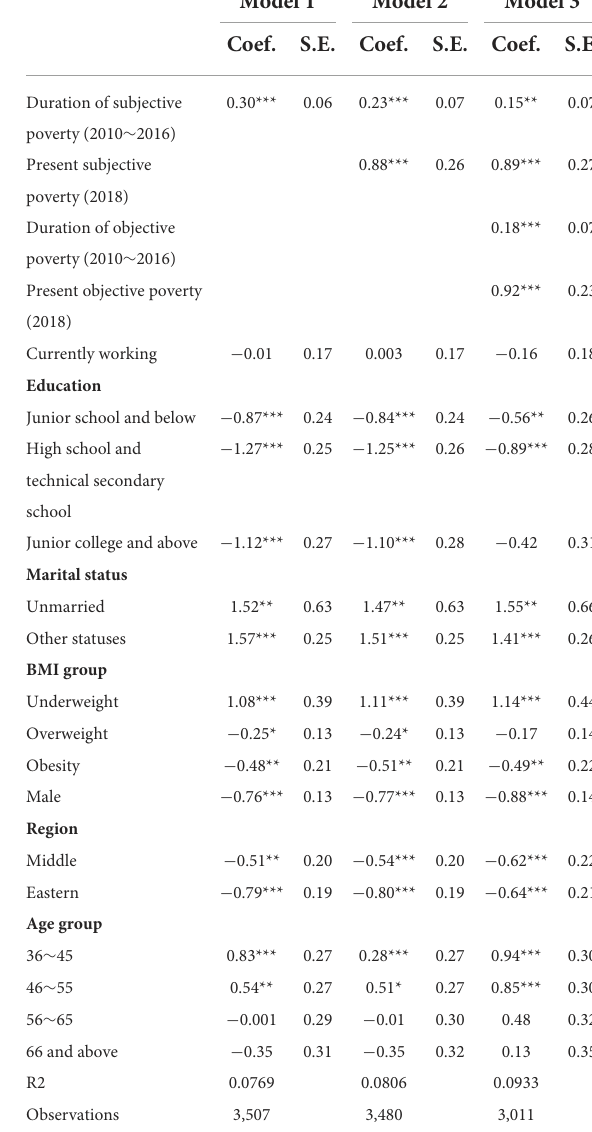
TABLE 6 Duration of subjective poverty and depressive symptoms in the total sample. Model 1